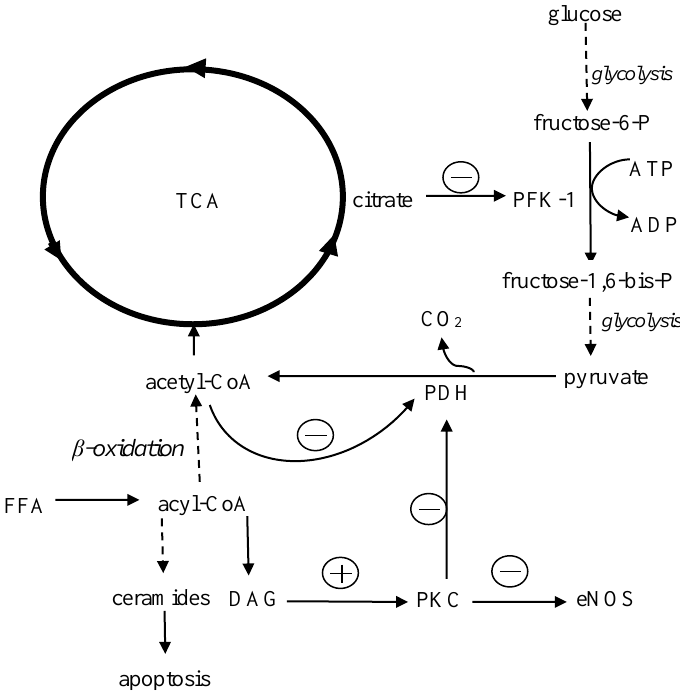
Figure 2. The impact of FFA overload on metabolism of the heart. Acetyl-CoA, acetyl coenzyme A; acyl-CoA, acyl coenzyme A; ADP, adenosine diphosphate; ATP, adenosine triphosphate; DAG, diacylglycerol; eNOS, endothelial nitric oxide synthase; FFA, free fatty acids; PDH, pyruvate dehydrogenase; PFK-1, phosphofructokinase 1; PKC, protein kinase C; and TCA, tricarboxylic acid cycle. Continuous and dotted arrows represent one- and multiple-step reactions, respectively. Arrows with circles containing “+” or “ − ” represent stimulatory and inhibitory effects,